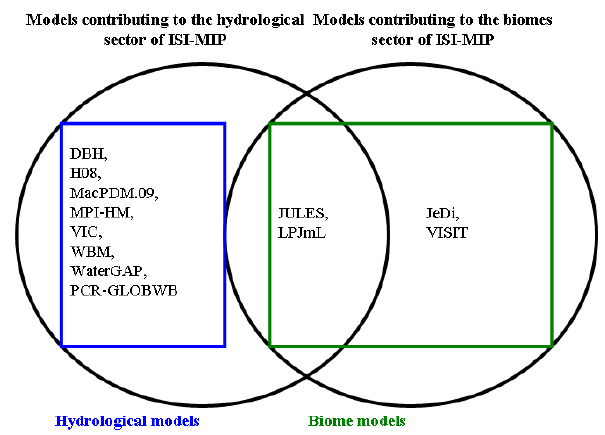
Fig. 1. Venn diagram to show the grouping of the impact models – the black circles show which models contributed to the biomes and hydrological sectors of ISI-MIP, with the overlap showing models which contributed output for variables in both sectors. The boxes with coloured outlines show the classification of models into groups within this study – the models within the blue box are included as hydrological models and the models listed within the green box are included as biome